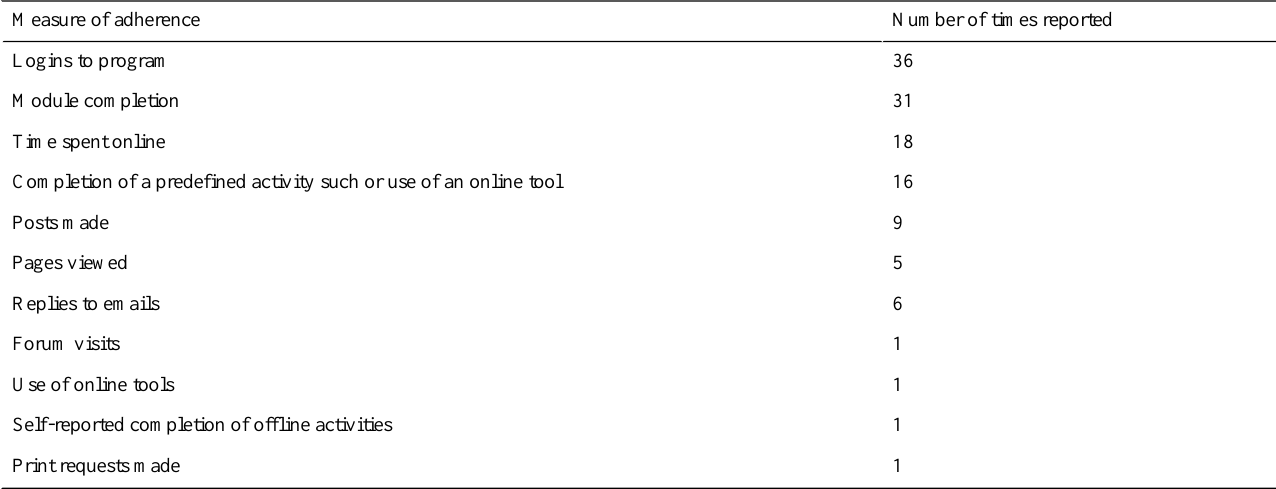
Table 2. Methods for measuring adherence to e-therapy as reported by included studies (n = 69)